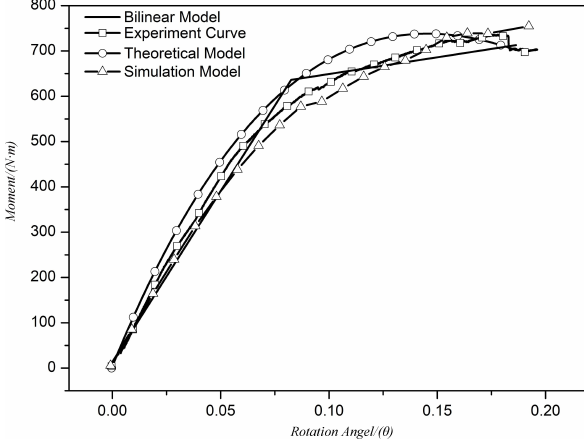
Figure 13: Comparison diagram between three models and experi- mental results